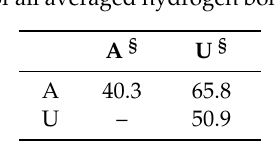
Table 1. Sum of all averaged hydrogen bond occupancies.